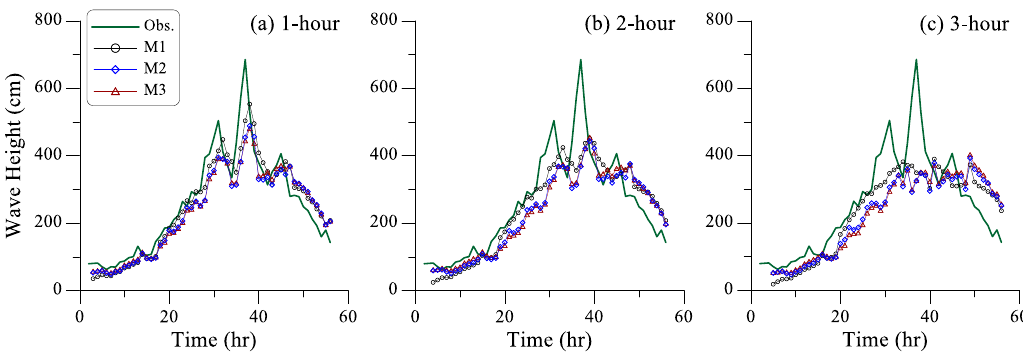
Figure 9. Real-time wave height forecasting with lead time of ( a ) 1, ( b ) 2, and ( c ) 3 h for Event 14 at Guishan Island.